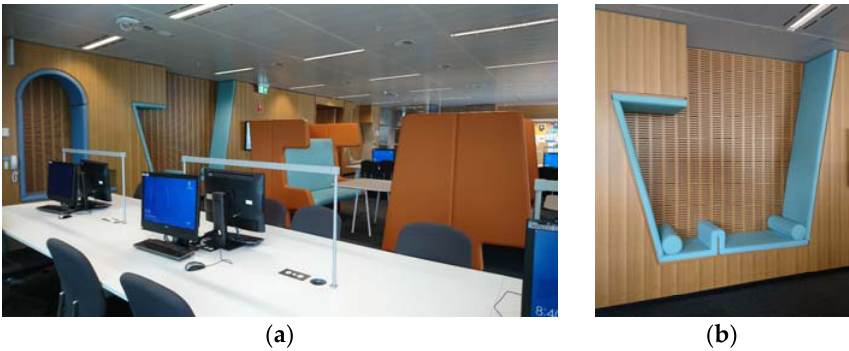
Figure 4. Level 5 southern study area, Jeffrey Smart Building, University of South Australia: ( a ) contextual view towards the southwest; and ( b ) wall chair detail (photos copyright of the author).